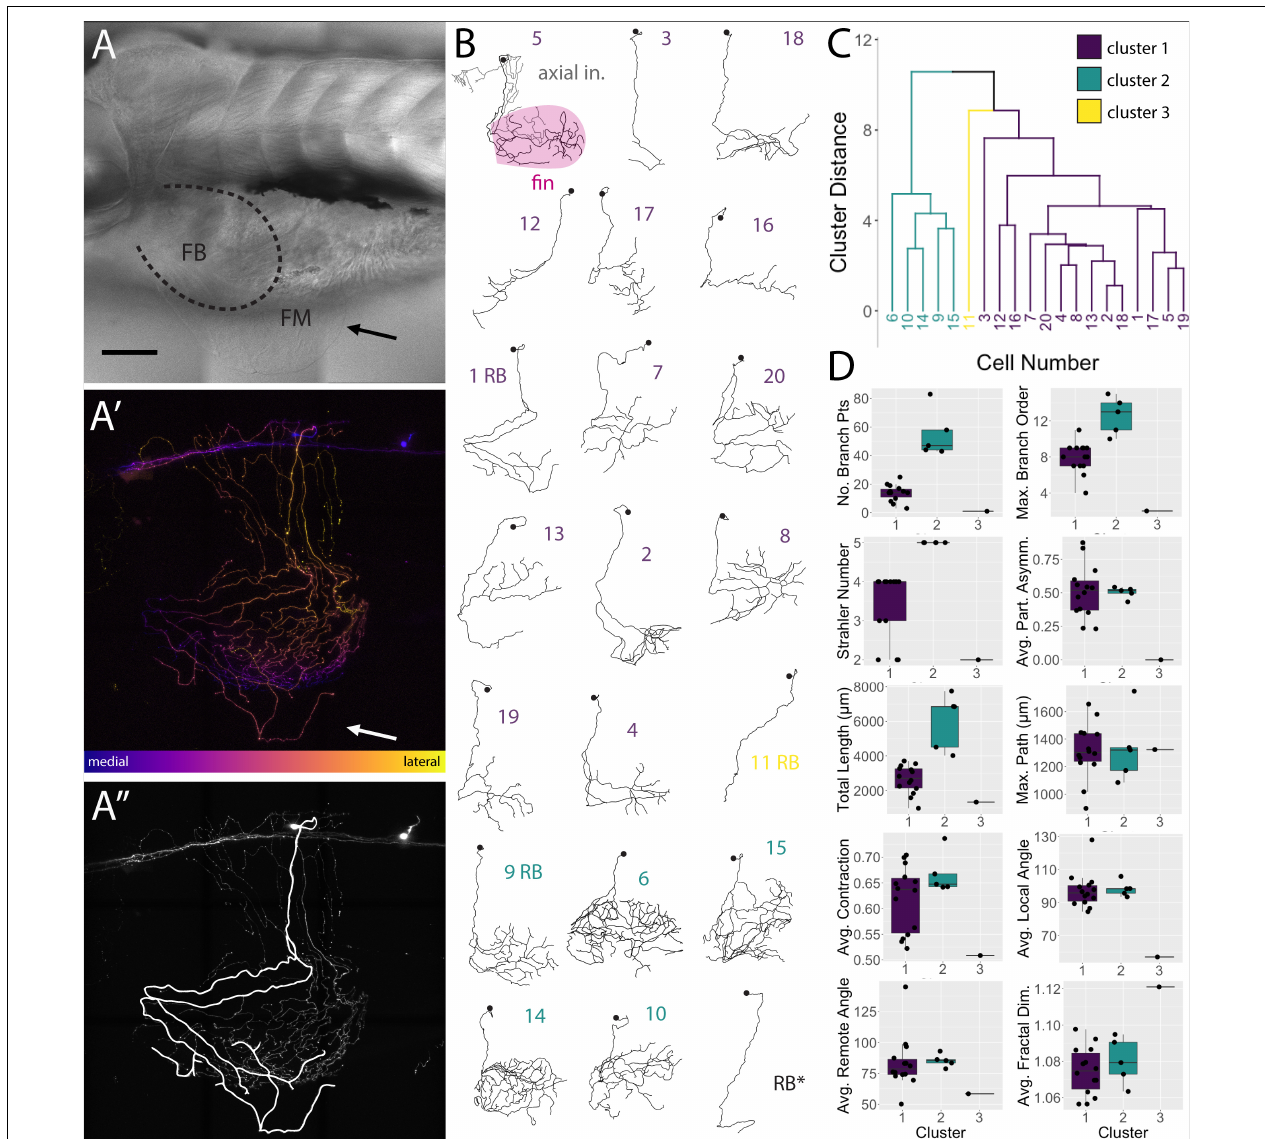
FIGURE 4 | islet2B + neurons innervating the fin fall into three distinct morphological clusters. (A) Brightfield image of 5 dpf larval zebrafish in lateral view. The fin is indicated with a black arrow, and the fin body (FB) is bounded by a dotted line indicating the position of the blood vessel separating the FB and the fin membrane (FM). (A (cid:48) ) A depth coded z-projection of a single islet2B+ neuron from the same fish in (A) shows an extensive arborization on the body and some sparse processes visible in the fin (white arrow). (A (cid:48)(cid:48) ) The same z-projection with an overlay of the reconstruction of the primary afferents projecting into the fin. (B) Reconstructions of the primary afferents innervating the fin show a diversity in both innervation pattern and fin coverage. The reconstruction in the top left has the axial innervation included in gray, the rest of the reconstructions are of only the fin innervation. The numbers are color coded to correspond to one of the three clusters in (C) . (C) Dendrogram of the results of agglomerative hierarchical clustering analysis using Ward’s method. There are three distinct clusters, color coded to reflect the number labels associated with the neuronal reconstructions in (B) . The y-axis indicates the Euclidean distance between clusters and leaves. (D) Box plots of each of the 10 morphological parameters, together with two soma parameters from Figure 3 , utilized in the cluster analysis. Boxes are color coded in accordance with cluster number, with the exception of cluster 3, which only contains one cell. Black point overlays indicate the individual values for each neuron. Anterior is to the left, dorsal is up in (A,A (cid:48) ,A (cid:48)(cid:48) ). Scale is 100 microns in (A) . N = 21 in (B) and 20 in (C,D) .